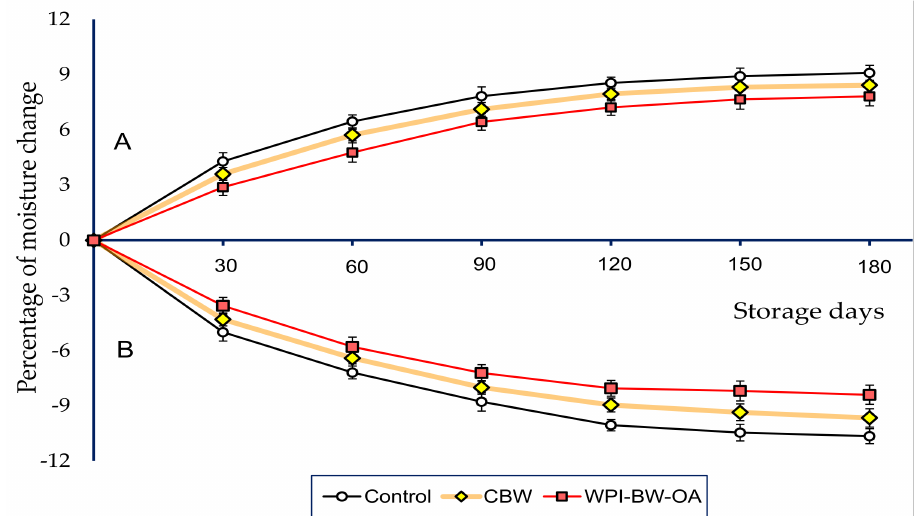
Figure 4. Effect of composite coating type and storage time on moisture changes of uncoated and coated semi-moist apricot cubes and cornflakes in apricot-cereals system: ( A ) cornflakes; and ( B ) semi- moist apricot cubes. Data are mean of triplicate measurements. Error bars indicate SD values. CBW,